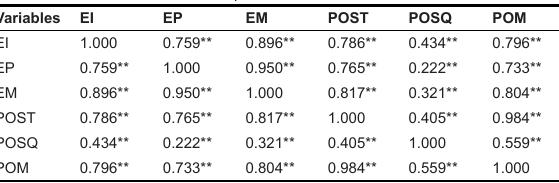
Matrix of intercorrelations of the Entrepreneurial orientation and Positive states